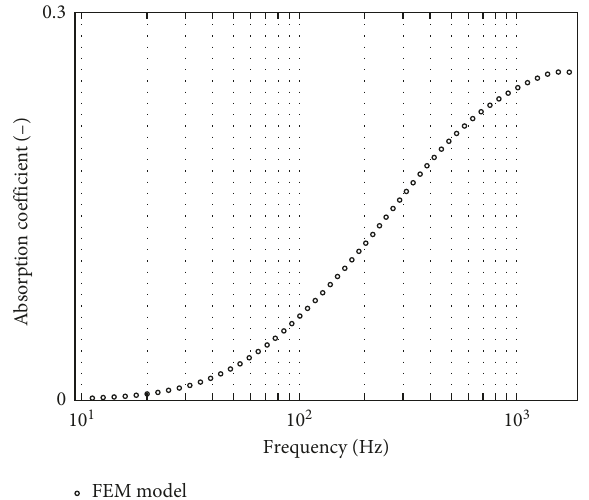
Figure 13: Numerical model for the attenuation in pure cement plaster.